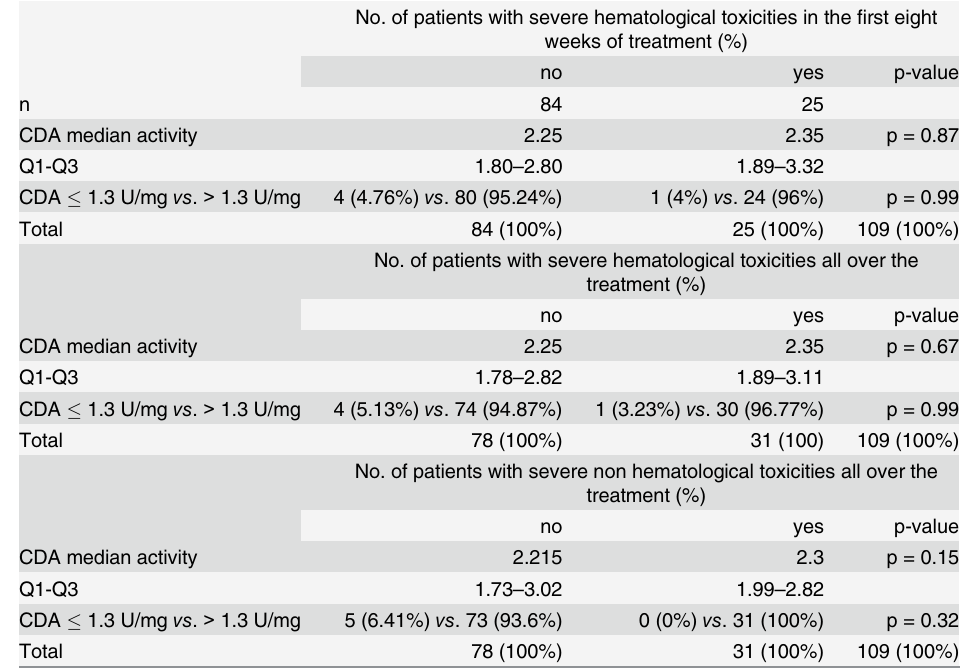
Table 3. Toxicities during treatment according to CDA activity (n =